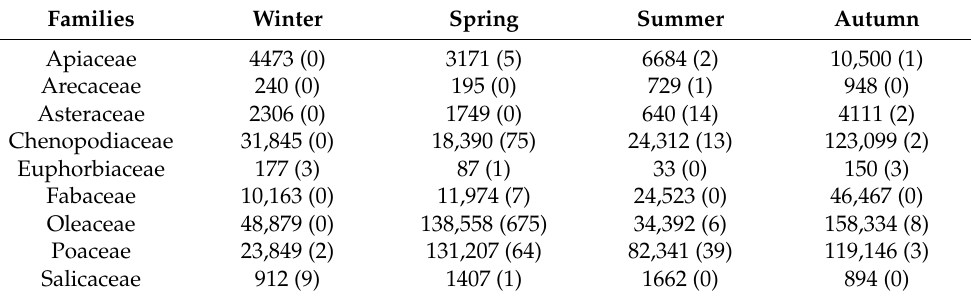
Table 5. Total read number of the nine Streptophyta families detected in Lecce across the four seasons and shared with Brindisi dataset, and the corresponding total pollen grain number of the same nine families detected in Brindisi (reported in